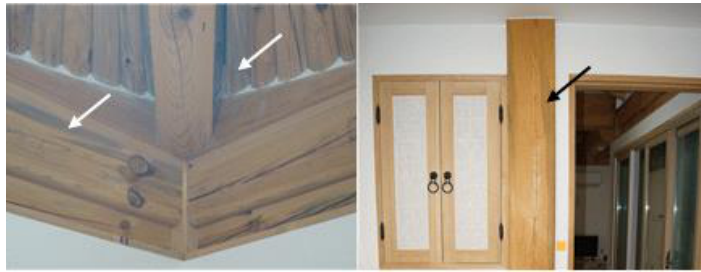
Figure 6. Hanok defects: bluish changes.